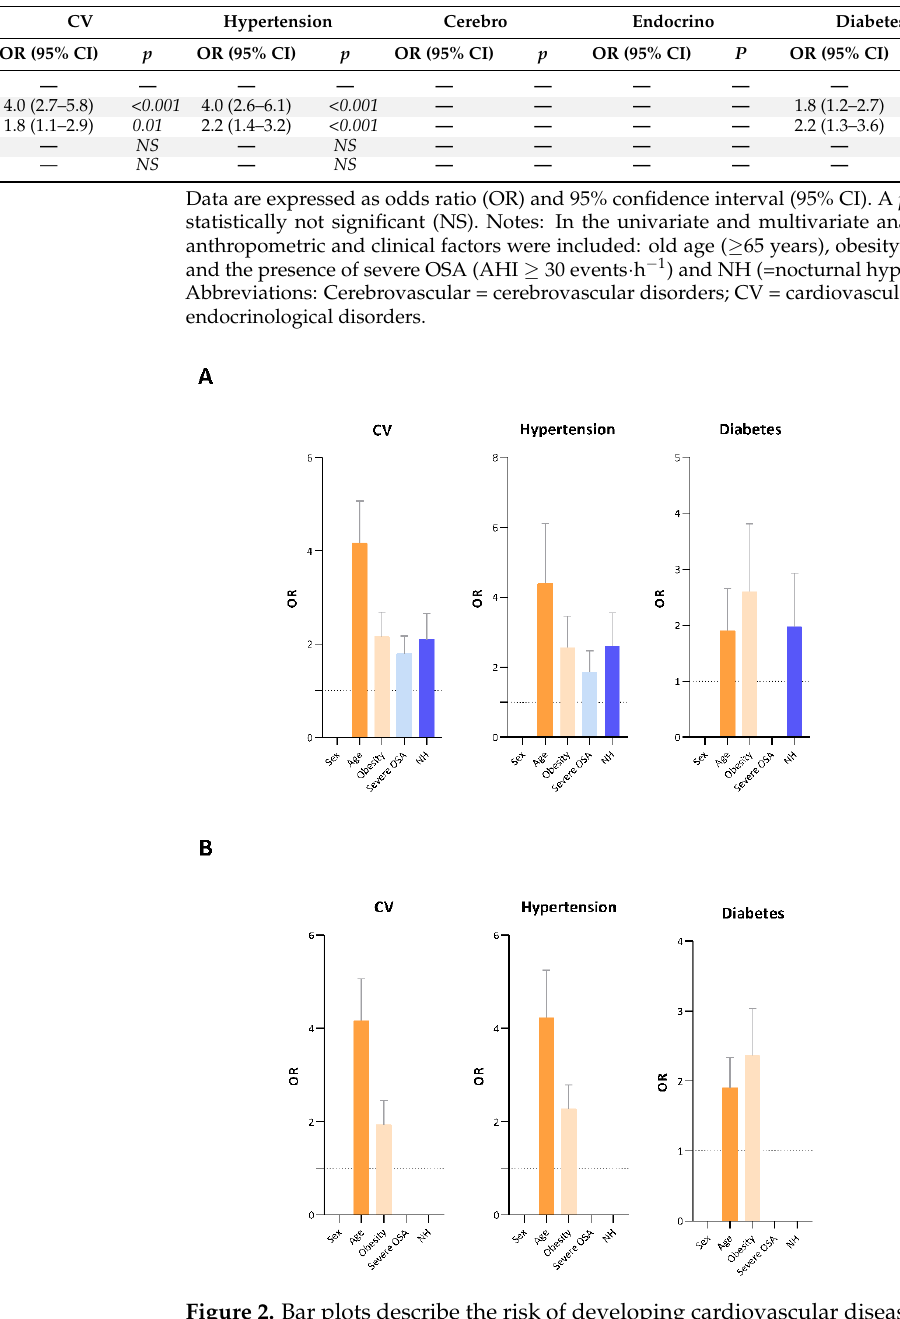
Figure 2. Bar plots describe the risk of developing cardiovascular diseases (CV), hypertension and diabetes by statistically significant variables analysed in ( A ) univariate logistic regression and ( B ) multivariate regression.